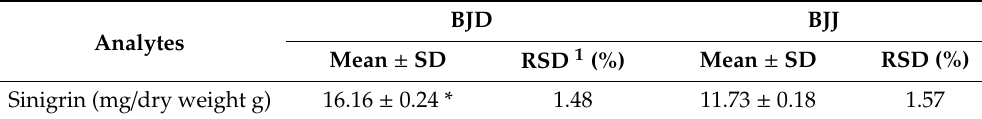
Table 7. The sinigrin content of BJD and